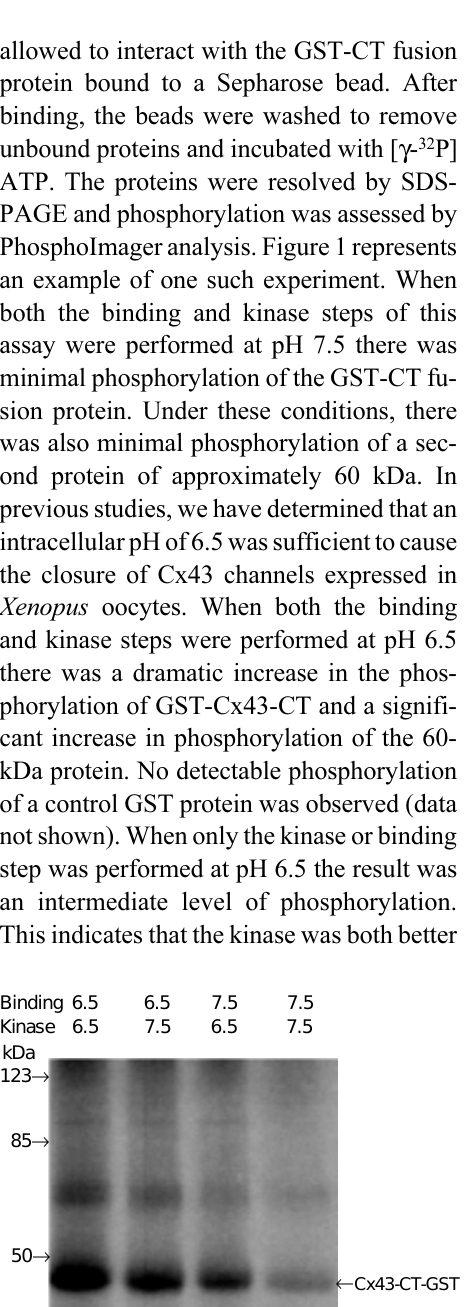
Figure 1 - Phosphorylation of Cx43. An in vitro kinase reaction was performed using a Cx43-CT- GST fusion protein. The fusion protein was immobilized on gluta- thione Sephadex resin and incu- bated with 1 mg of sheep heart extract for 90 min. Binding reac- tions were performed in MOPS buffer at either pH 6.5 or 7.5. Af- ter washing, the beads were incu- g bated with 5 µCi of [ - 32 P] ATP in 50 mM MOPS and 3 mM MnCl 2 at the pH indicated. The reaction was stopped by the addition of SDS sample buffer and the pro- teins were resolved by SDS- PAGE. Visualization was per- formed using a PhosphoImager. The image shown was represen- tative of at least three experi- ments. The migration of the Cx43- CT-GST fusion protein is marked. Phosphorylation is enhanced when the binding and/or kinase incubations are at pH 6.5. CT-GST, Carboxy terminal-glutathione-S- transferase fusion